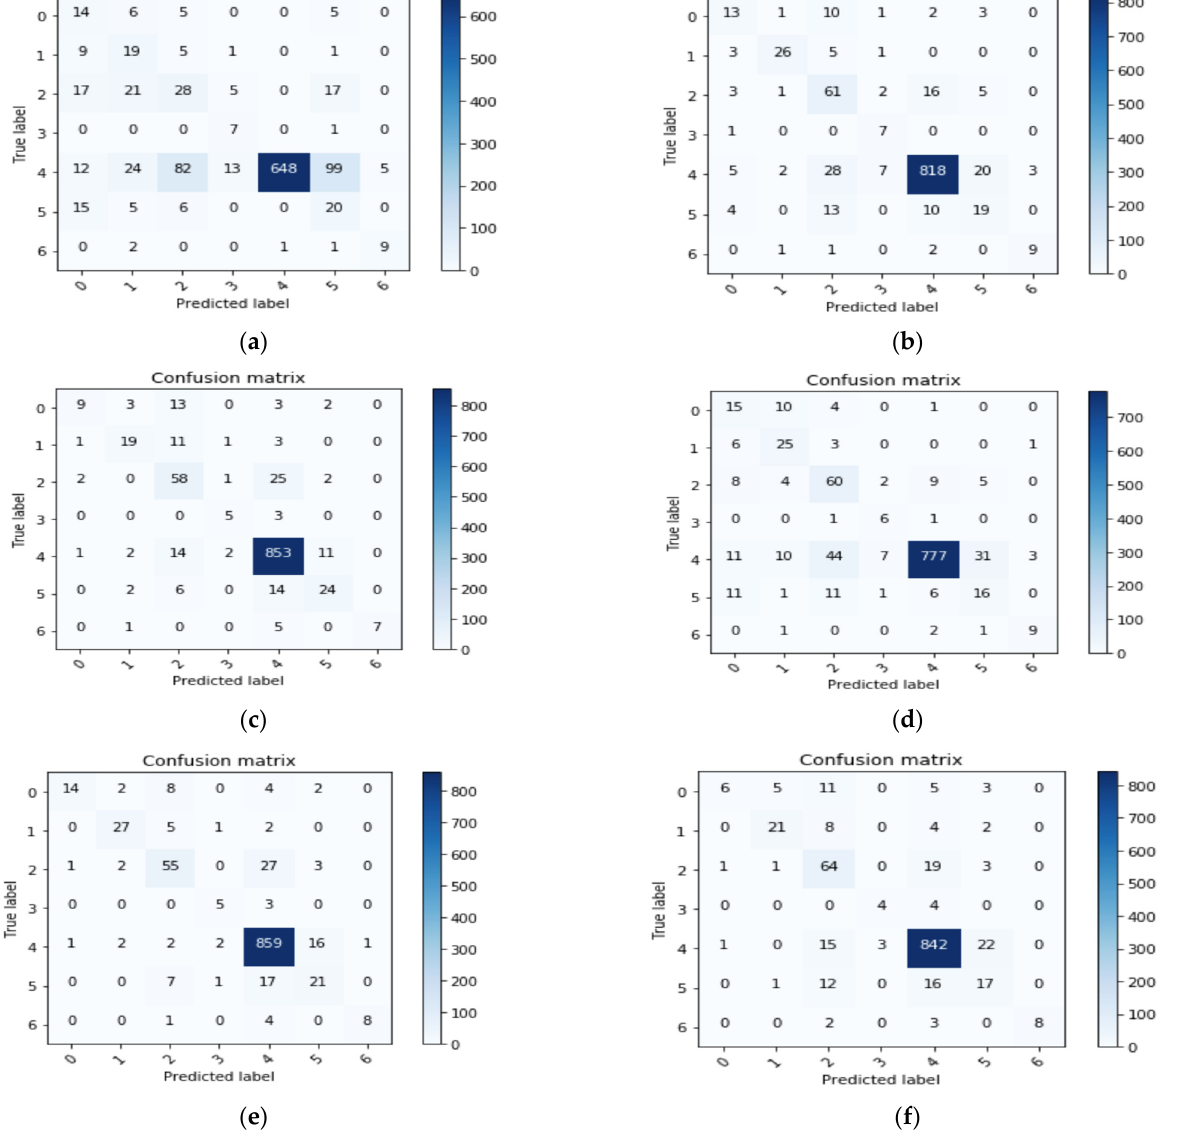
Figure 4. Confusion matrix results of different nets: ( a ) VGG19; ( b ) InceptionV3; ( c ) InceptionResNetV2; ( d ) ResNet50; ( e ) Xception; ( f ) MobileNet.